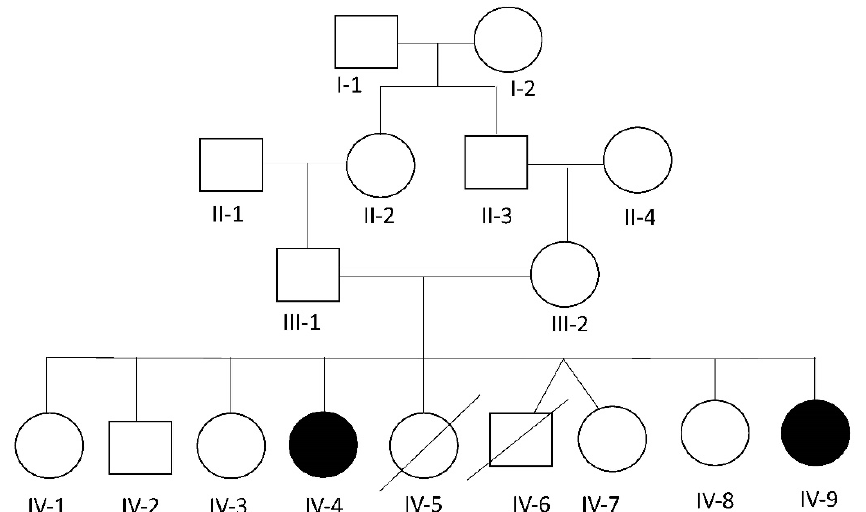
Figure 1. Pedigree of the reported family. Black color represents the affected individuals. Arrows indicate the affected individuals included in this study.